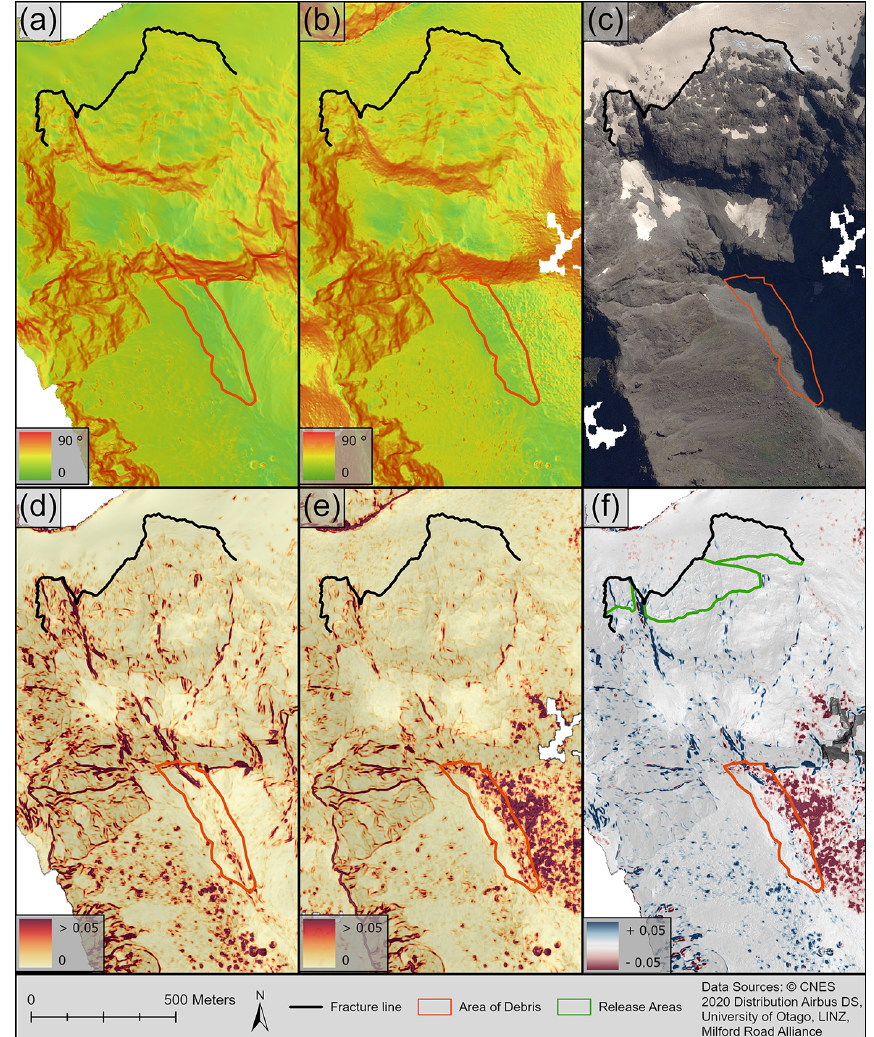
Figure 10. Composite map comparing slope angle and surface roughness for the TLS-derived 2m DSM and satellite-derived (SPM) 2m DSMs. Panel (a) shows TLS 2m slope angle, panel (b) shows SPM 2m slope angle, and panel (c) is the SPM ortho-image showing fracture line and debris area. Panel (d) is TLS 2m surface roughness, panel (e) is the SPM 2m surface roughness, and panel (f) is the difference in surface roughness between TLS and SPM 2m DSMs, which also shows the digitized release areas used in the